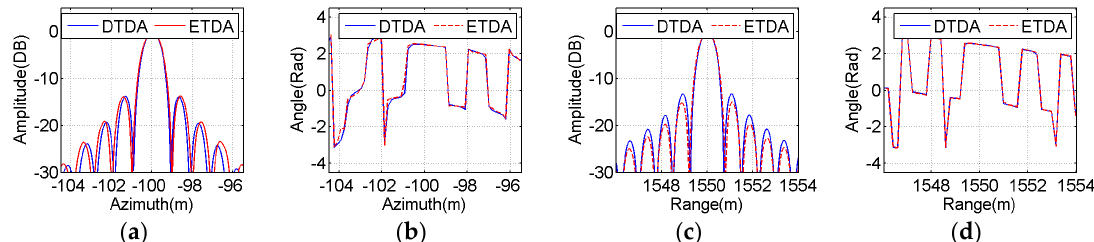
Figure 13. Comparison between the focused results obtained by the bistatic DTDA and proposed ETDA for the point-like scatterer G. ( a ) Azimuth amplitude; ( b ) Azimuth phase; ( c )Range amplitude; ( d ) Range phase.